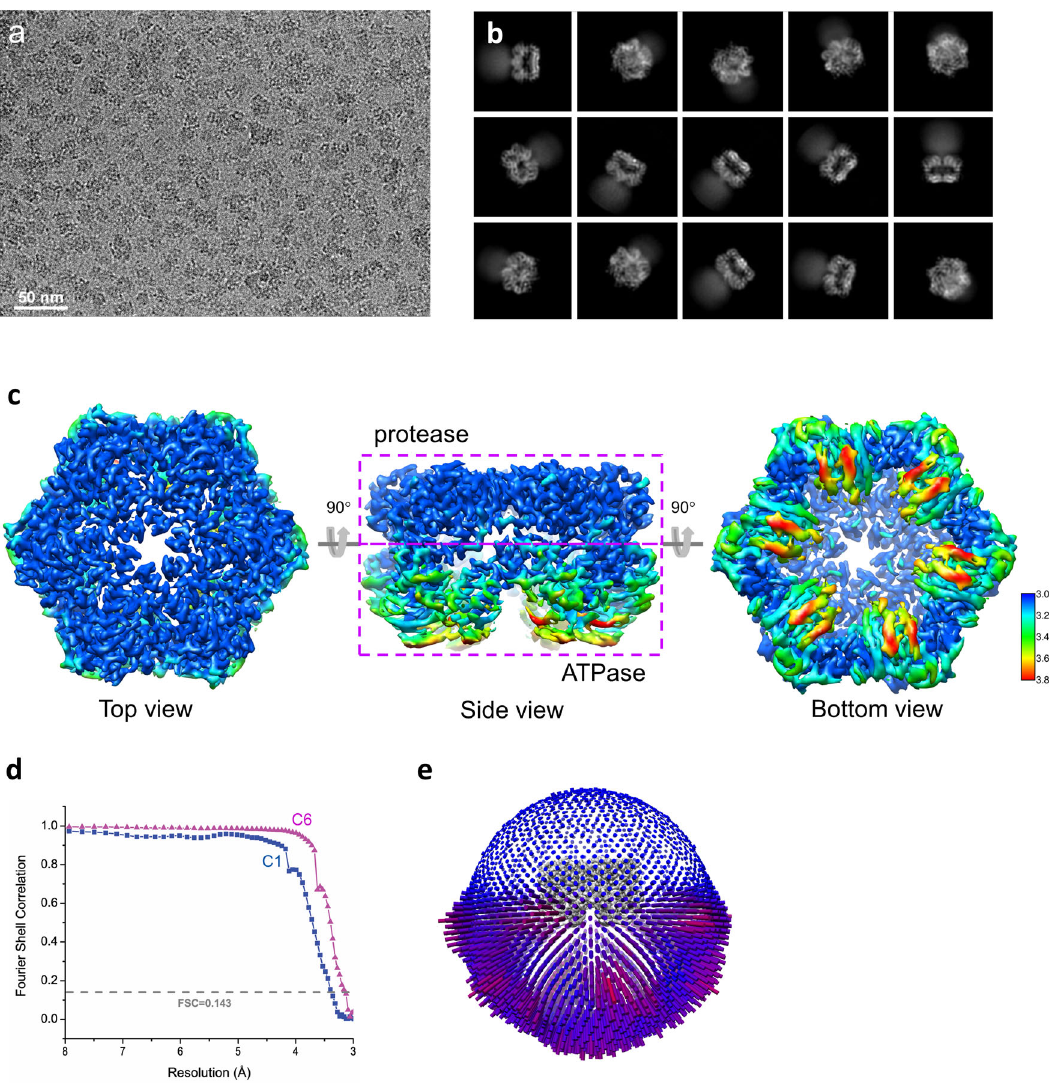
Fig. 2 Determination of Tm FtsH structure in ADP state. a A typical motion-corrected cryo-EM micrograph from a total of 11,169 micrographs. b 2D class averages. c Three views for the reconstructed map colored with local resolutions. d Fourier Shell Correlation (FSC) curve for the 3D reconstruction to determine the structure resolution. e Orientation distribution for particles used in the fi nal 3D